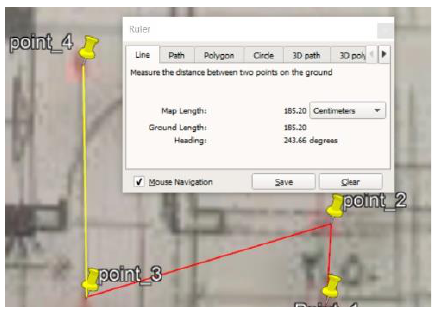
Figure 30. Length and heading to point_3.